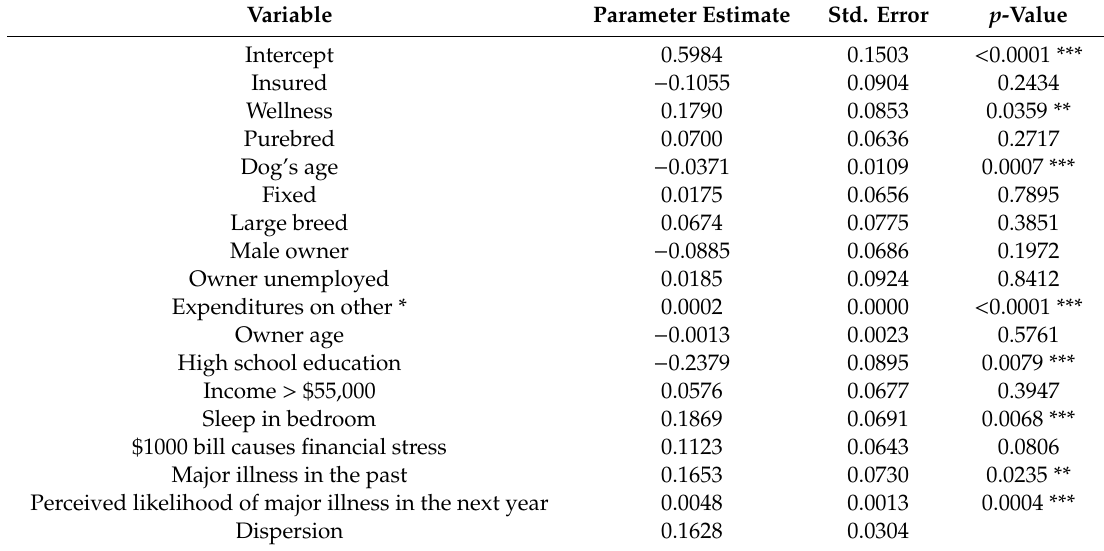
Table 4. Negative binomial count model with number of visits as the dependent variable.